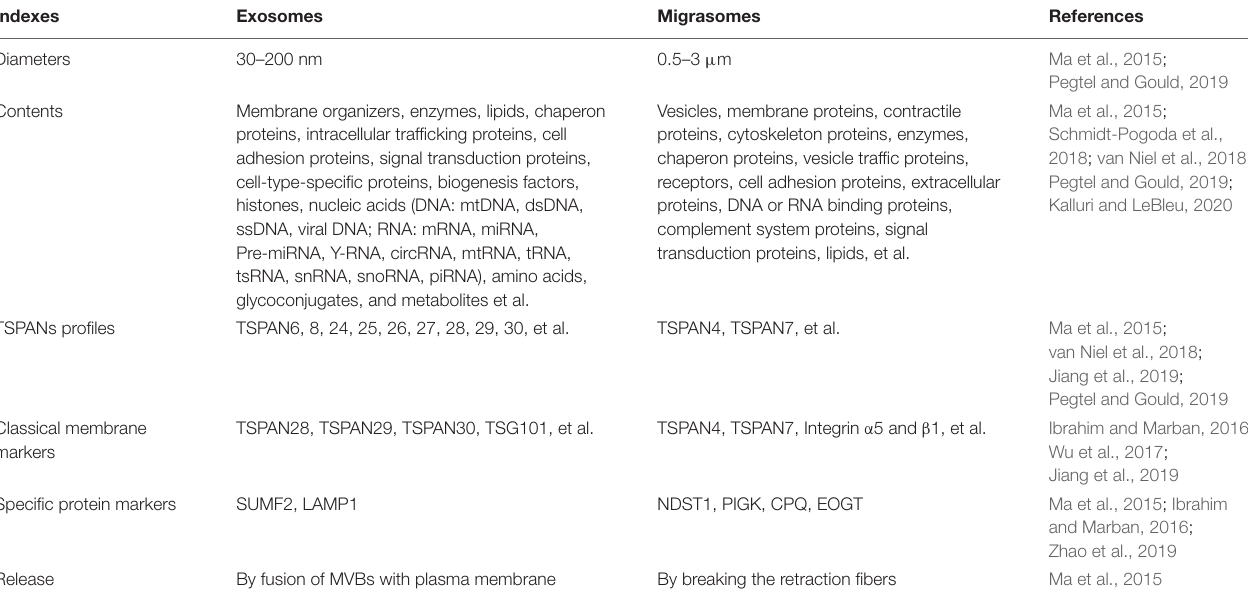
TABLE 1 | The basic characteristics of migrasomes and